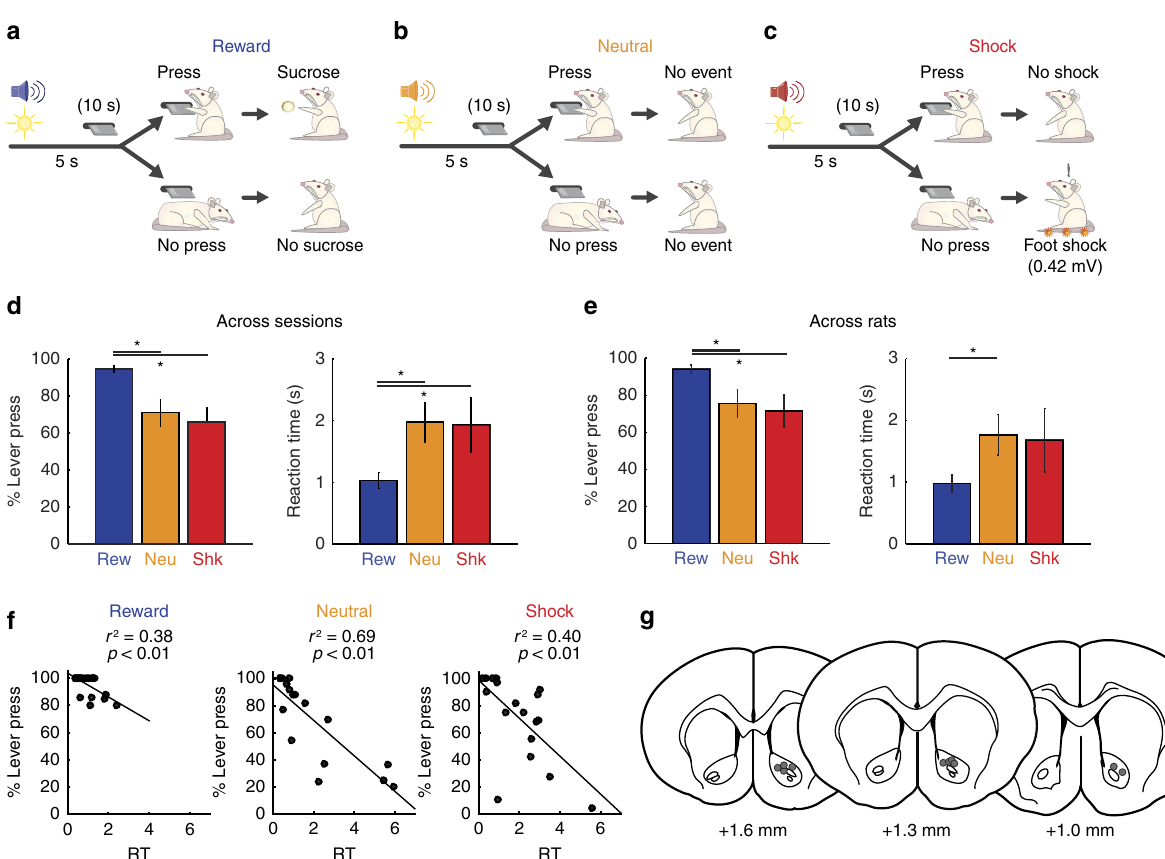
Figure 1 | Task design and population behavioural results ( N ¼ 10 rats; 18 sessions). Sessions consisted of 3 trial types: reward ( a ), neutral ( b ), and shock ( c ), which could be identified by their unique auditory cue. ( a – c ) At the beginning of each trial, rats were presented with a light cue and trial-specific sound cue 5s before lever extension and then had a maximum of 10s to press the lever before it was retracted. If rats pressed the lever, they could receive a sucrose pellet reward, avoid an impending foot shock (0.42mV), or experience no consequence, depending on the identity of the sound cue. If rats failed to press the lever within 10s after its extension into the chamber, they would alternatively receive no sucrose reward, receive continuous foot shock (0.42mV), or experience no consequence depending on the identity of the sound cue. Once shock commenced, it could be terminated by lever press. After each consequence, the trial progressed into a 20s ITI. Trial types were pseudo-randomly interleaved within each session ( B 60 min) and sound cue identity was counterbalanced across rats. ( d , e ) Percent lever press and reaction time computed across each session ( d ) and across rats ( e ). Bars